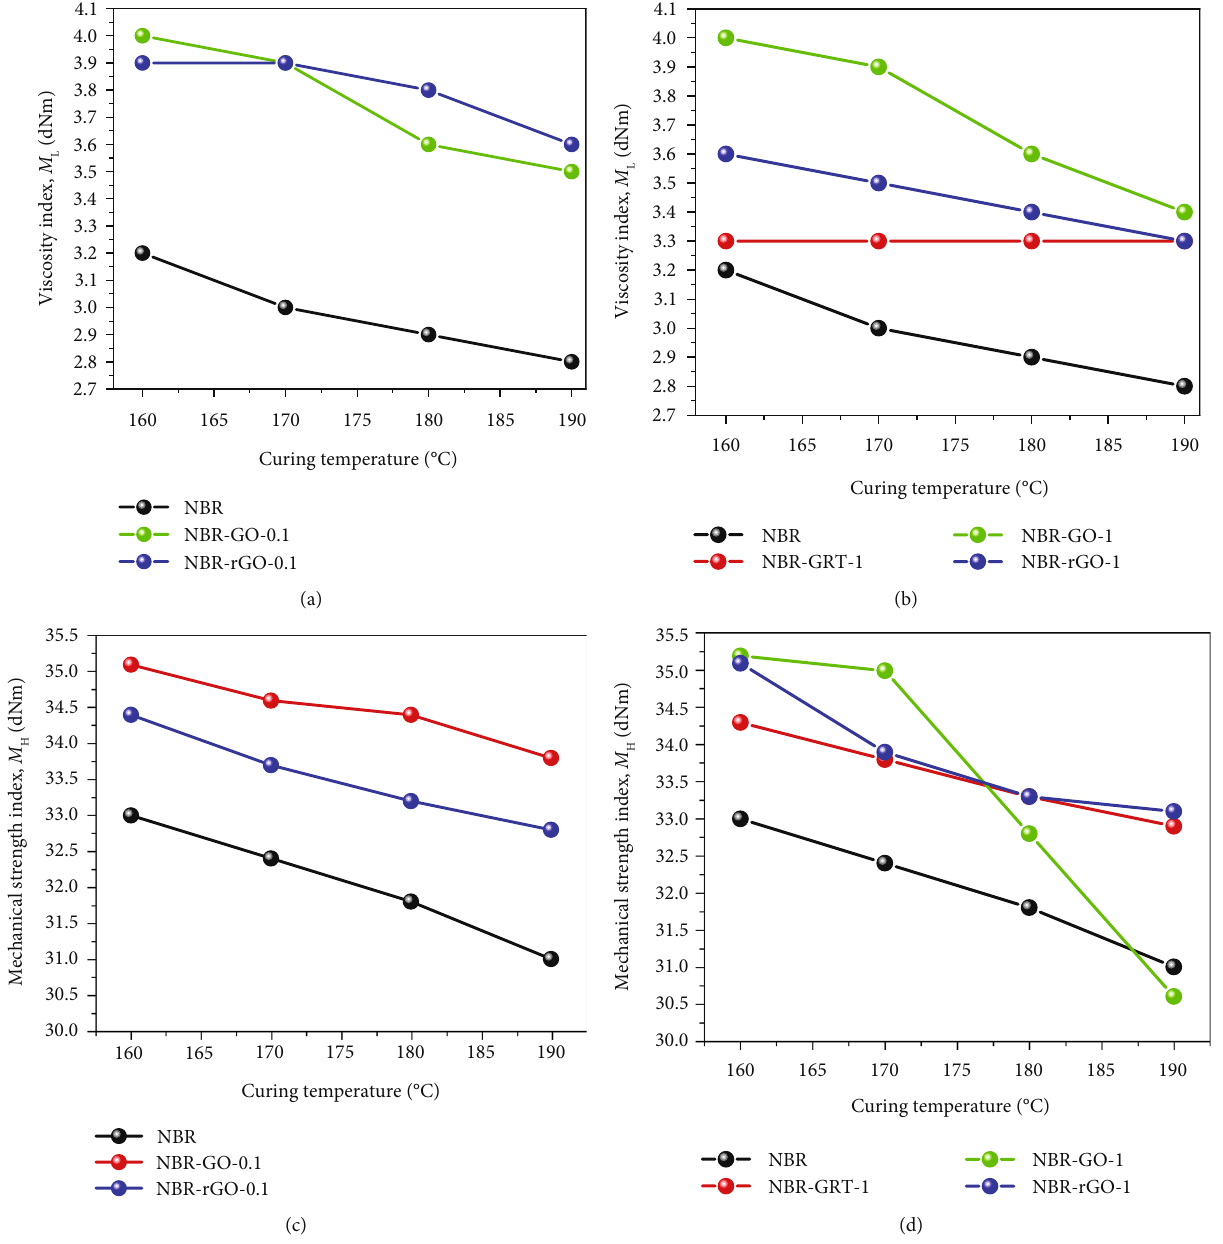
Figure 9: Mechanical strength index and viscosity index from the rheometer. (a) Viscosity index ( M ) of 1 phr fi lled compounds. (c) Mechanical strength index ( M Viscosity index ( M L ) of 1 phr fi lled strength index ( M H